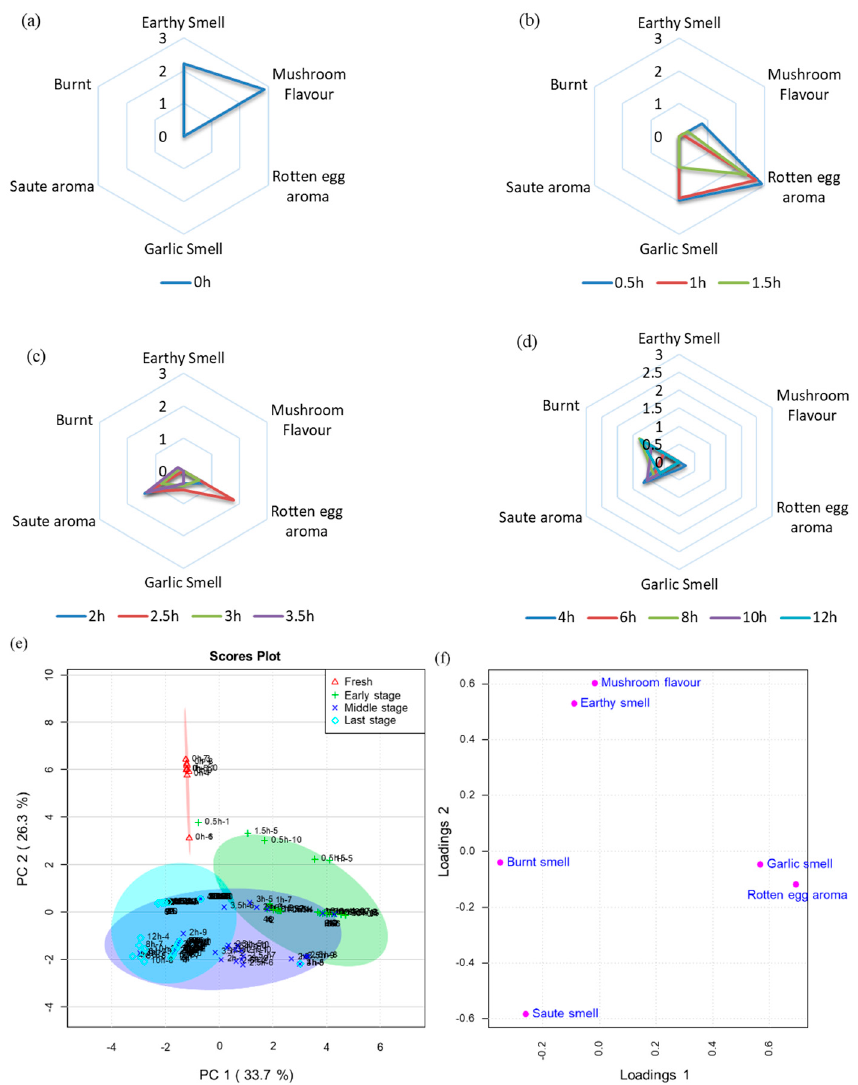
Figure 2. ( a ), ( b ), ( c ) and ( d ) radar fingerprint chart of sensory evaluation for L. edodes at different drying times; ( e ) principal component analysis (PCA) scores scatter plot; ( f ) Loading plot of PCA.